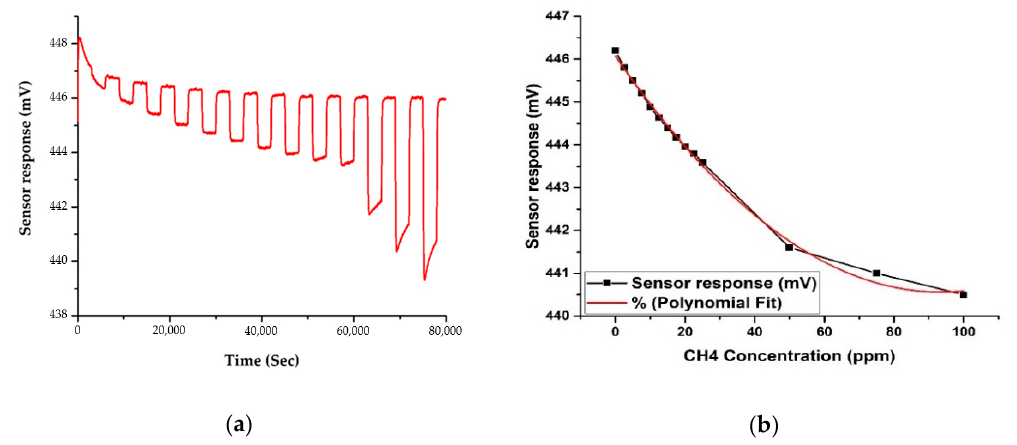
Figure 11. Sensor response to CH 4 gas with different concentrations, from 2.5 ppm to 100 ppm, at 7.8 µm: ( a ) sensor response; and ( b ) polynomial fit (R-Square = 0.997).